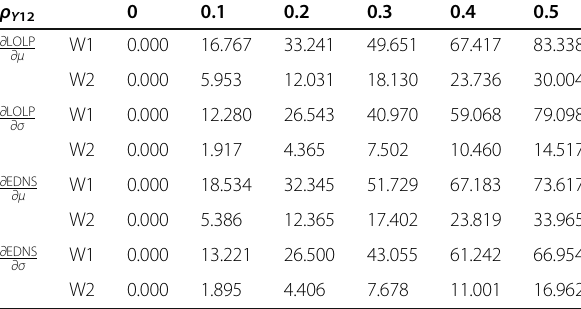
Table 3 Relative error of sensitivity